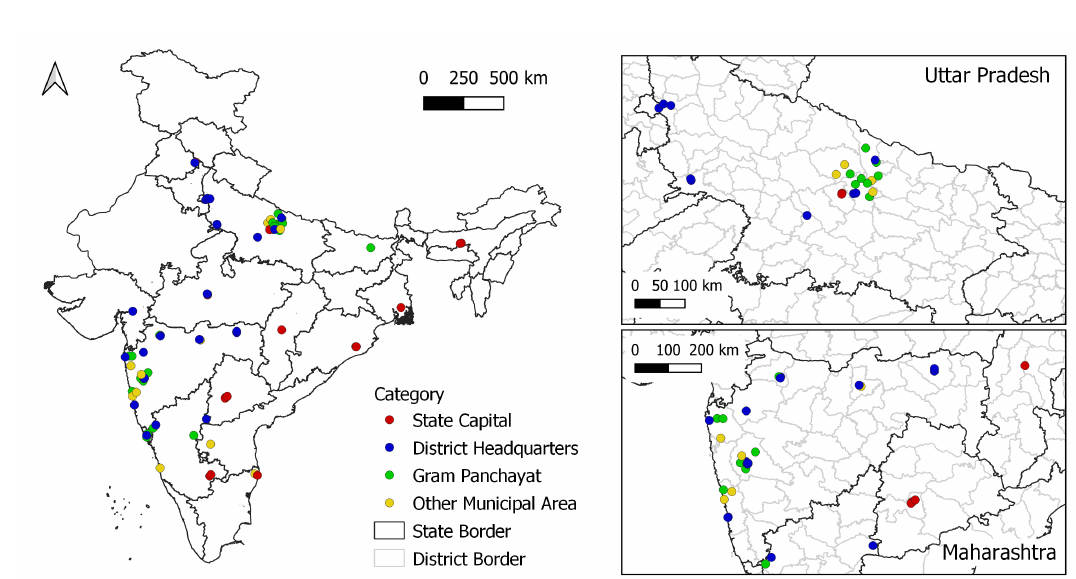
Figure 3. Map showing the location of ESMI voltage monitor